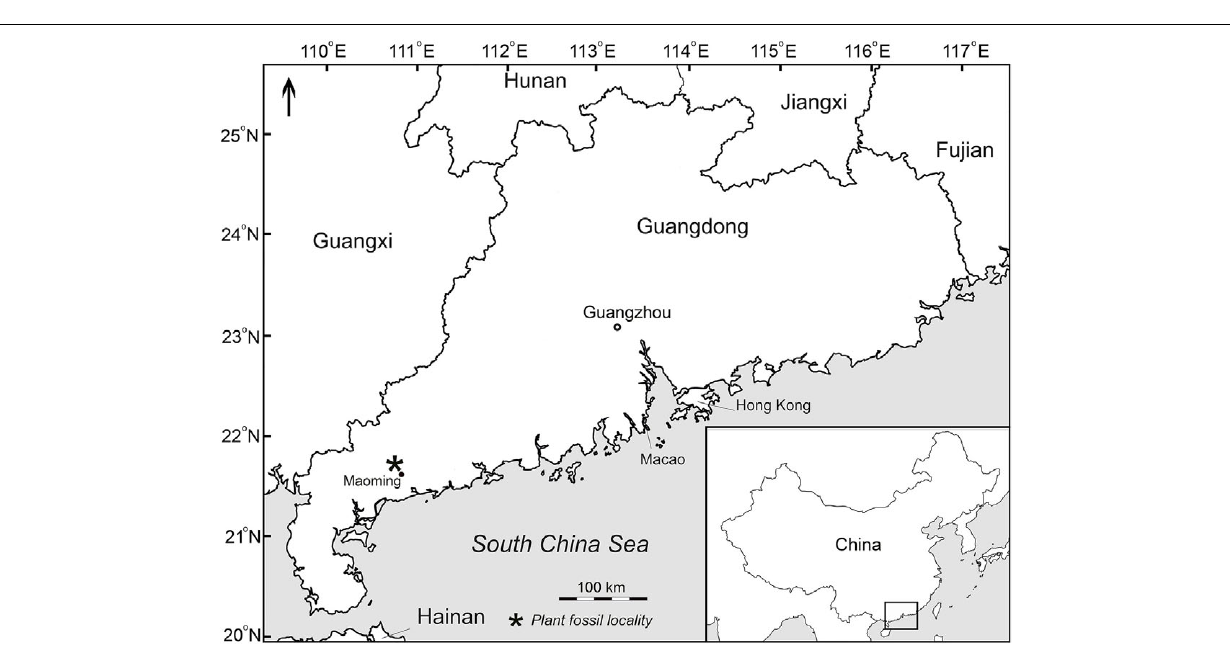
at the Borissiak Paleontological Institute, Russian Academy of Sciences (PIN